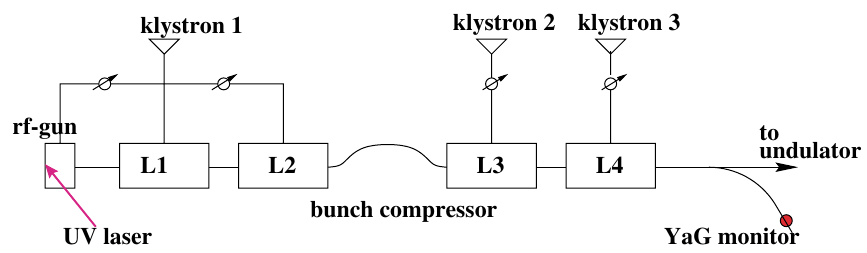
FIG. 2. (Color) Overview of the deep ultraviolet free-electron laser (DUV-FEL) accelerator. L1, L2, L3, and L4 are the four linac